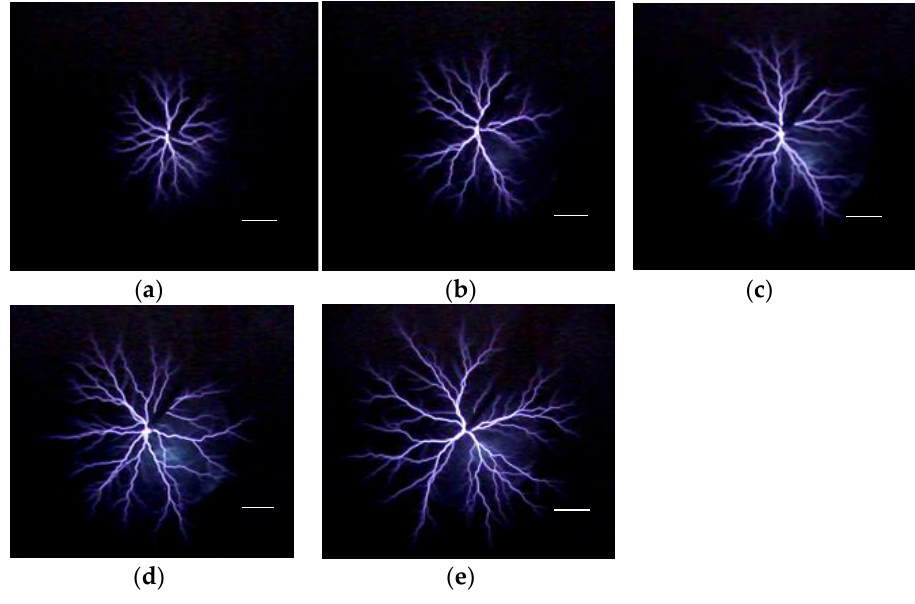
Figure 2. Images of streamer discharges at water surface captured by using a high speed video camera at applied voltages of ( a ) 9.1; ( b ) 11.6; ( c ) 14.0; ( d ) 16.5; and ( e ) 21.6 kV (scale bar = 5 mm).